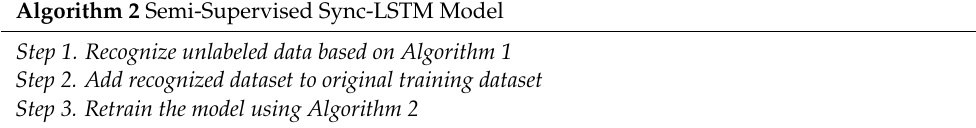
Algorithm 2 Semi-Supervised Sync-LSTM